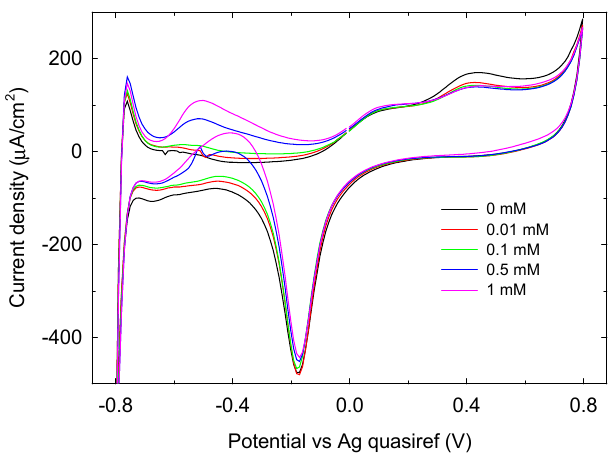
Figure 9. CV of phosphate buffer 0.1 M LIFT treated Pt SPE in the presence of glucose concentration ≤ 1 mM.